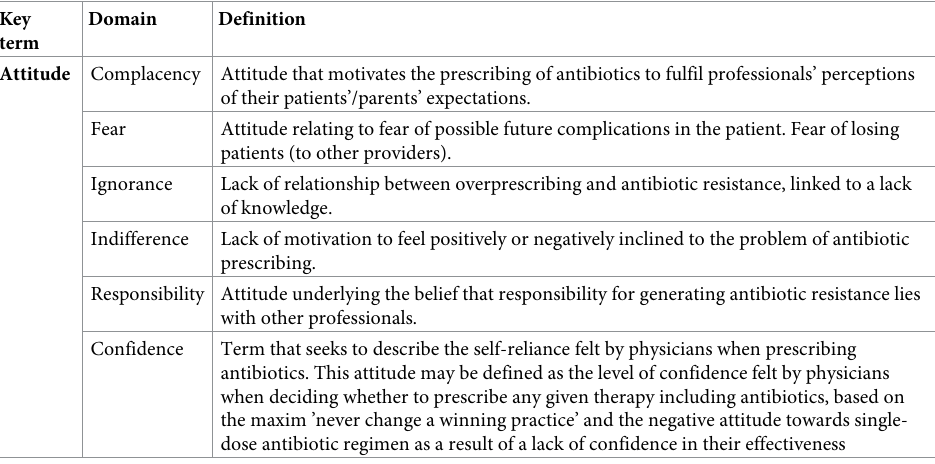
Table 3. Conceptualisation of